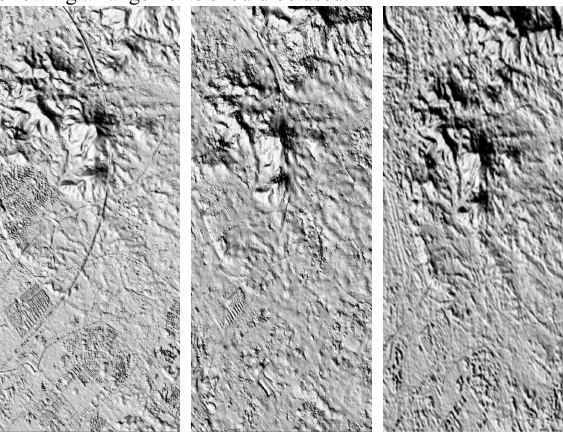
Figure 8 Comparative analysis of DEM model from iteration and fusion technology by TerraSAR-X/TanDEM-X images, AW3D30 and